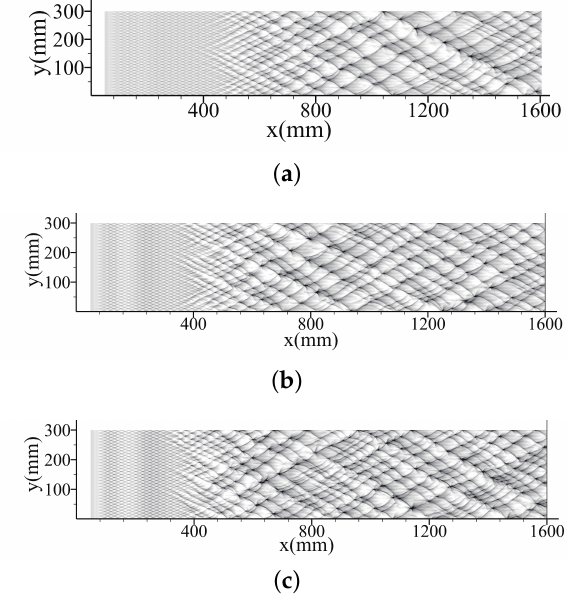
Figure 7. Numerical smoked foils for cases with artificial perturbations of A = 15 K, s = 10 ∆ I , ( a ) k R = 2 s − 1 , ( b ) k R = 3 s − 1 , and ( c ) k R = 4 s − 1